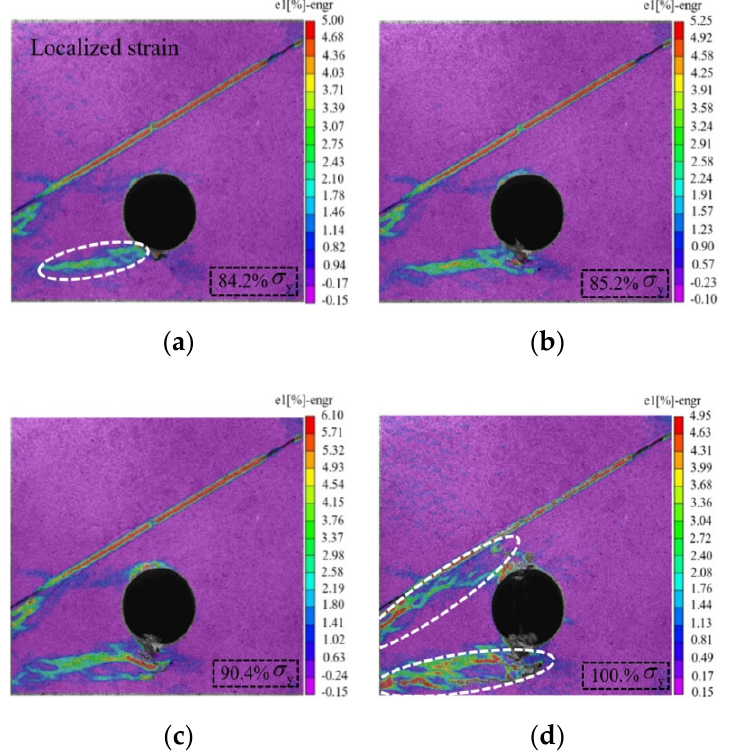
Figure 19. Evolution of the major principal strain field of sample A ‐ 30. ( a ) 84.2% σ y ; ( b ) 85.2% σ y ; ( c ) 90.4% σ y ; ( d ) 100% σ y . ( c ) 90.4% σ y ; ( d ) 100% σ y